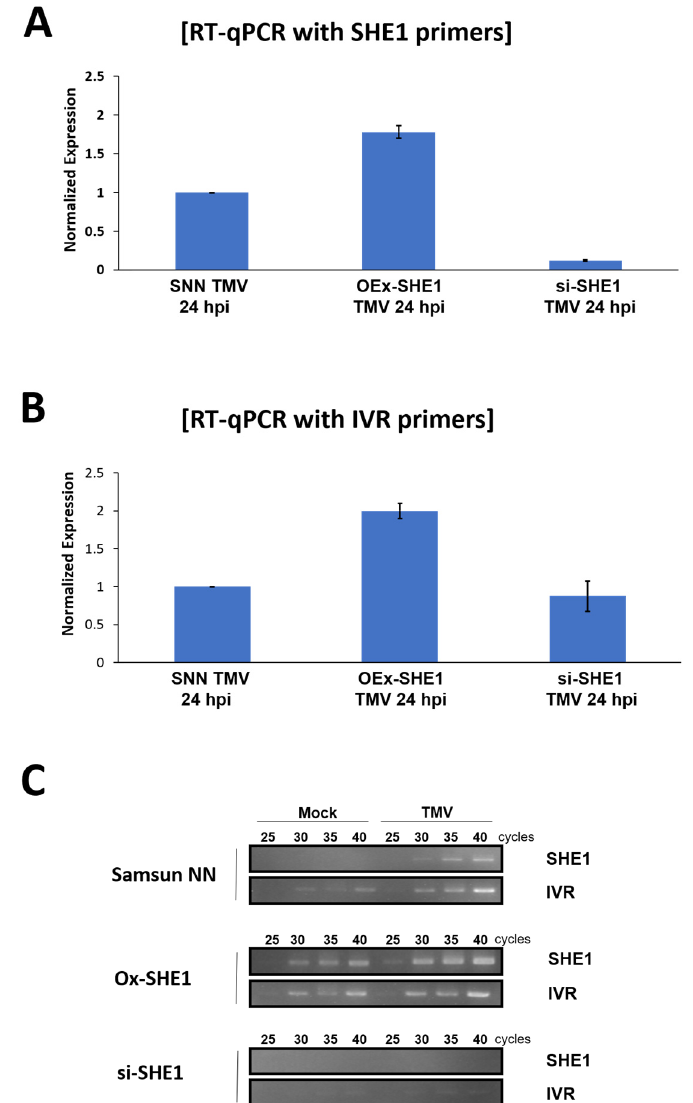
Figure 5. Analysis of SHE1 and IVR mRNA accumulation in nontransformed (SNN) and transgenic Samsun NN tobacco plants. Plants were transgenic for either overexpression of SHE1 (OEx-SHE1) or silencing of expression of SHE1 (si-SHE1). Plants were inoculated with TMV. Total RNAs from healthy and inoculated leaves were extracted and processed at 24 h post inoculation, followed by either RT-qPCR analysis ( A and B ) or semi-quantitative RT-PCR analysis ( C ), for the level of ( A ) SHE1 mRNA, ( B ) IVR mRNA or ( C ) both. The mRNA from eIF1 α was used as a reference standard.